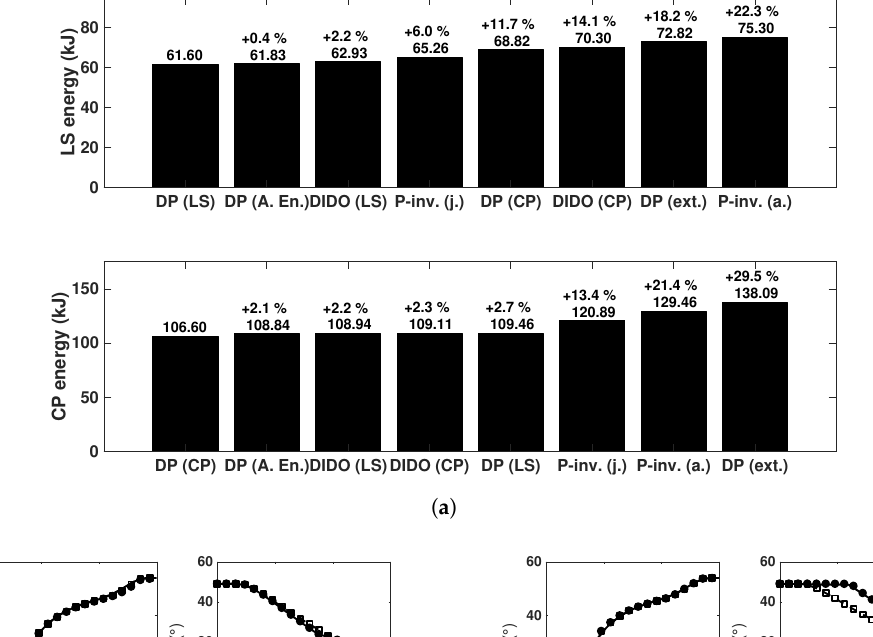
). Sub-optimal (cid:32) ). (cid:32)